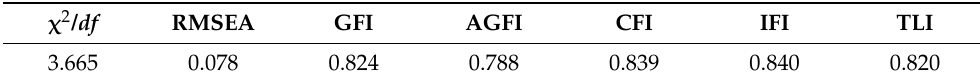
Table 10. Overall Fitting Coefficient of Initial